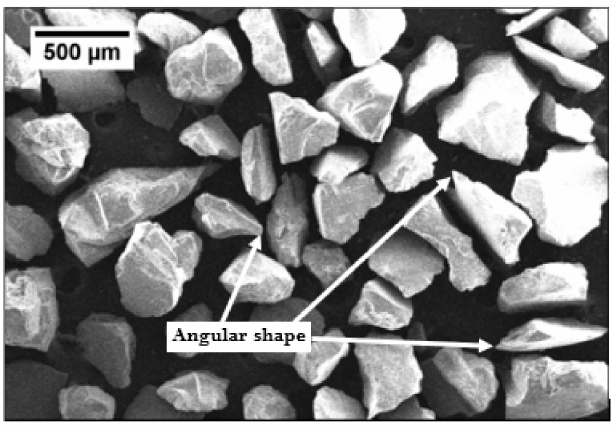
Figure 5. The geometry of quartz